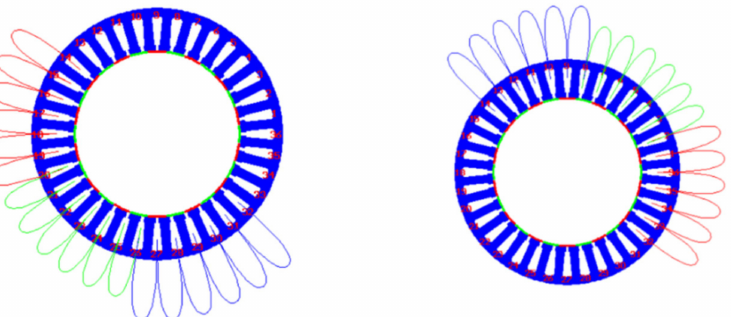
Figure 6. First example of a winding system which allows a geometrical decoupling of the main- and redundant winding system (winding scheme by placing the main-/redundant at each half of the stator: 18 coils main on the left motor half and 18 coils redundant on the right motor part).